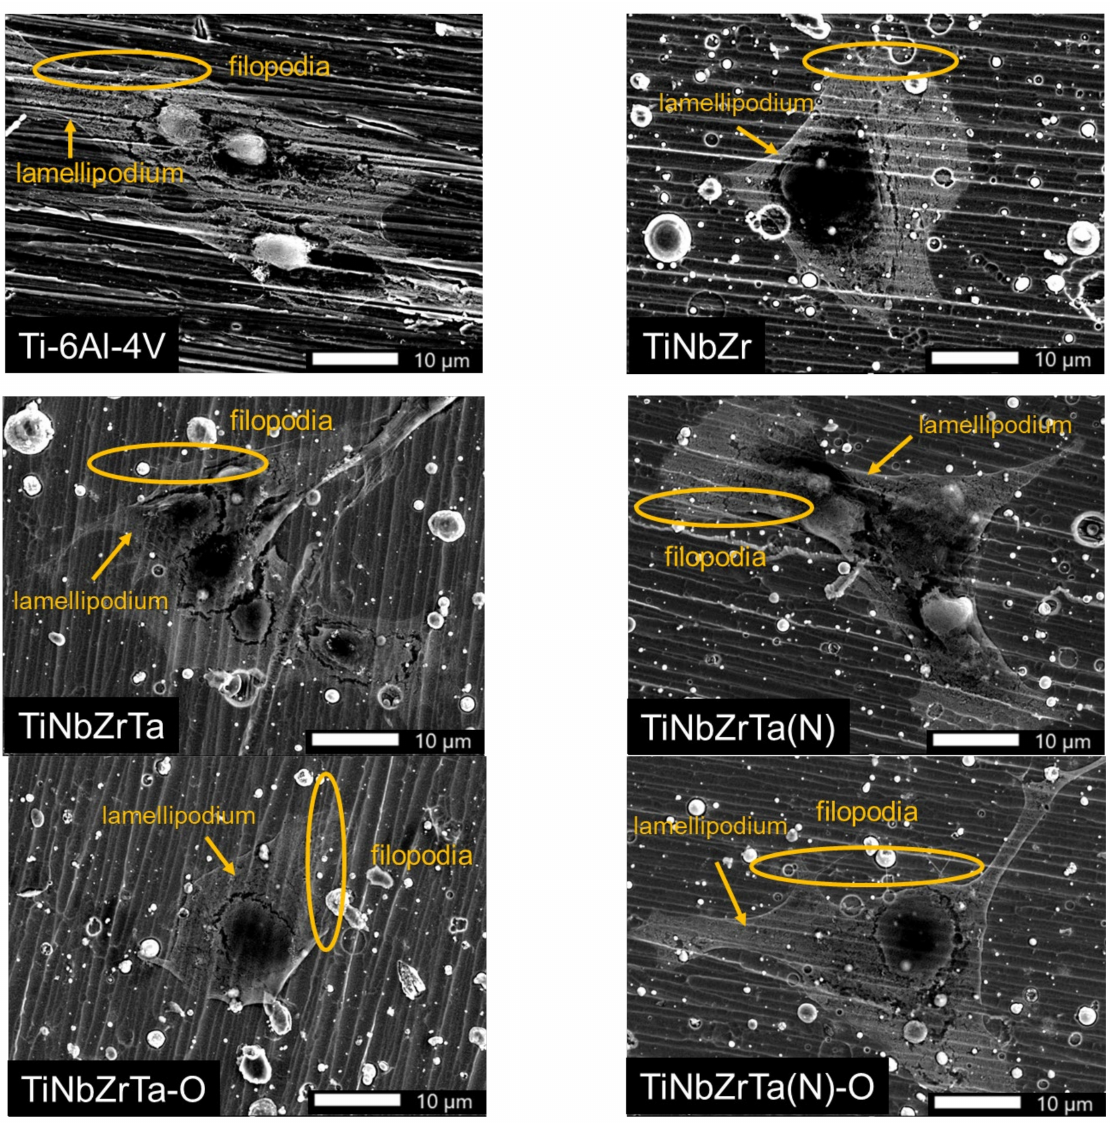
Figure 10. SEM images of MG-63 cells cultured on Ti-6Al-4V, TiNbZr, TiNbZrTa, TiNbZrTa(N), TiNbZrTa-O, and TiNbZrTa(N)-O for 48 h. The scale was 10 µ m (1000 × magnification from the raw images). The arrows indicate lamellipodia, and the circles indicate